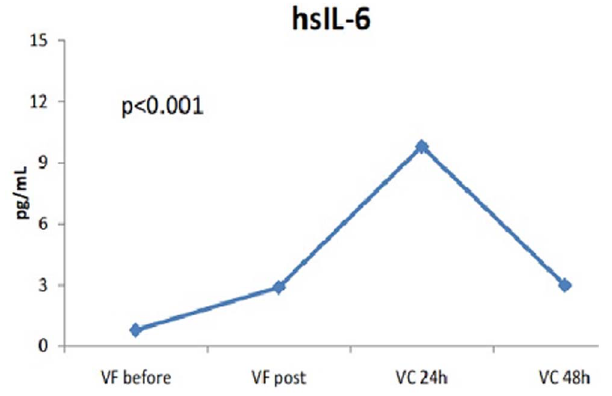
Figure 2. Changes in interleukin-6 levels after catheter ablation.